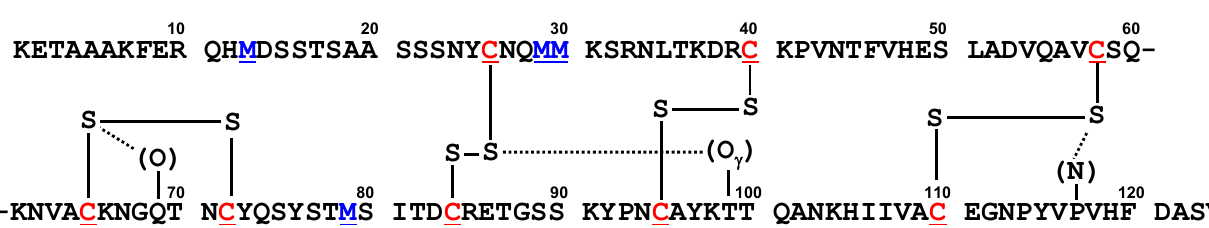
Figure 9. The amino acid sequence of bovine RNase A with notations of common S···X interactions.